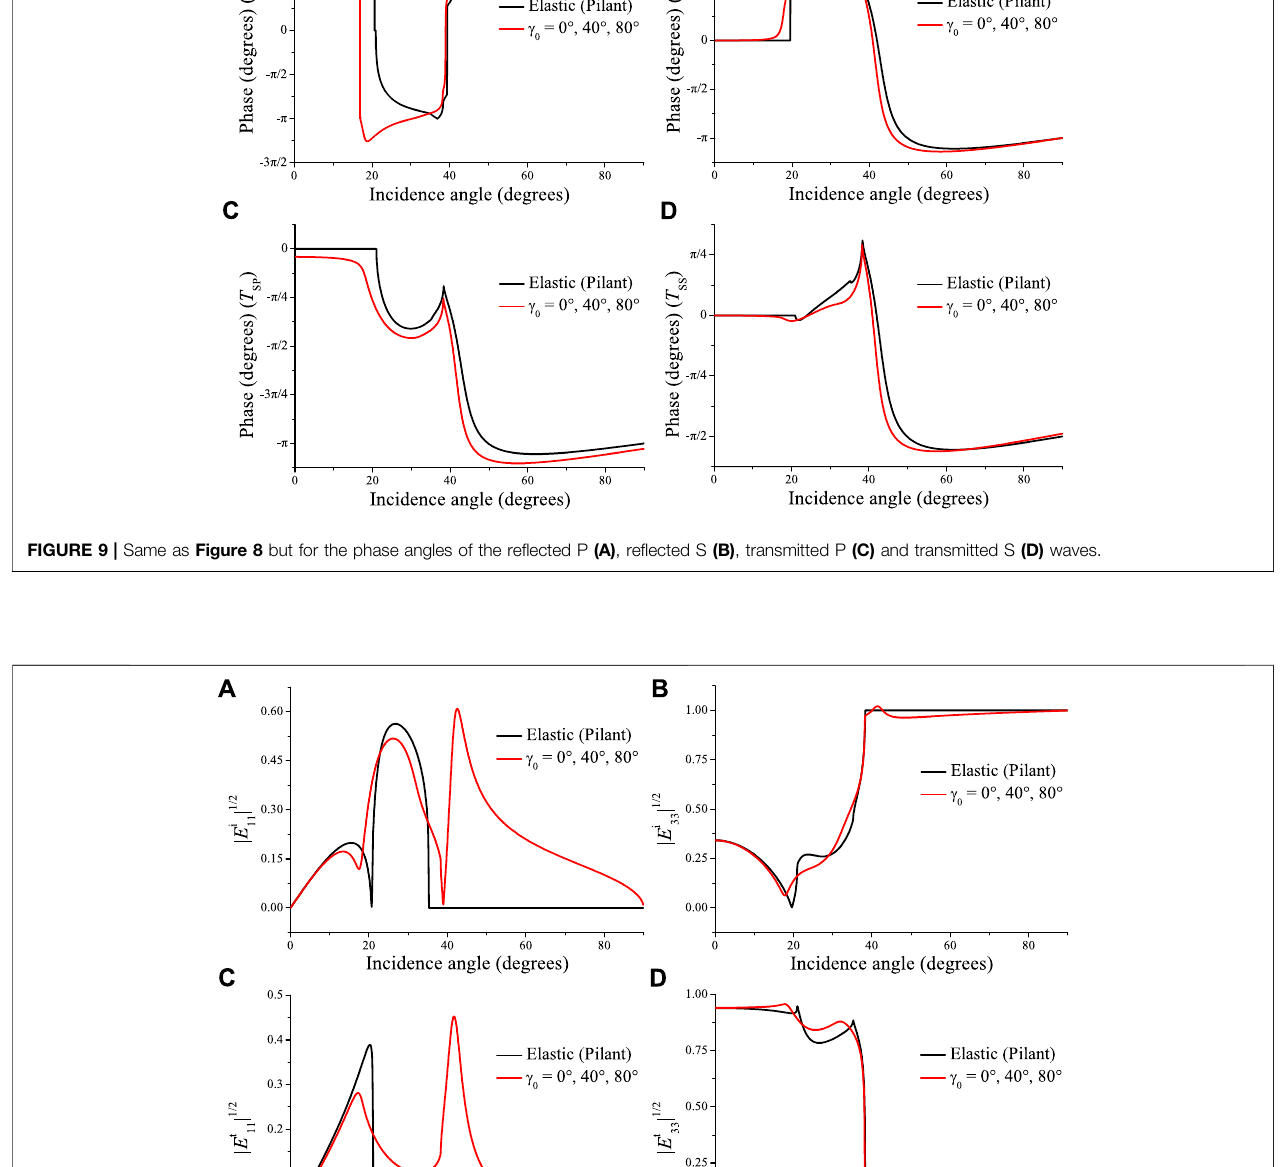
and transmitted longitudinal waves without conversion to the shear modes. The incident P wave is homogeneous when γ 0 = 0 ° , and the behavior of the curves is close to that of the elastic case.